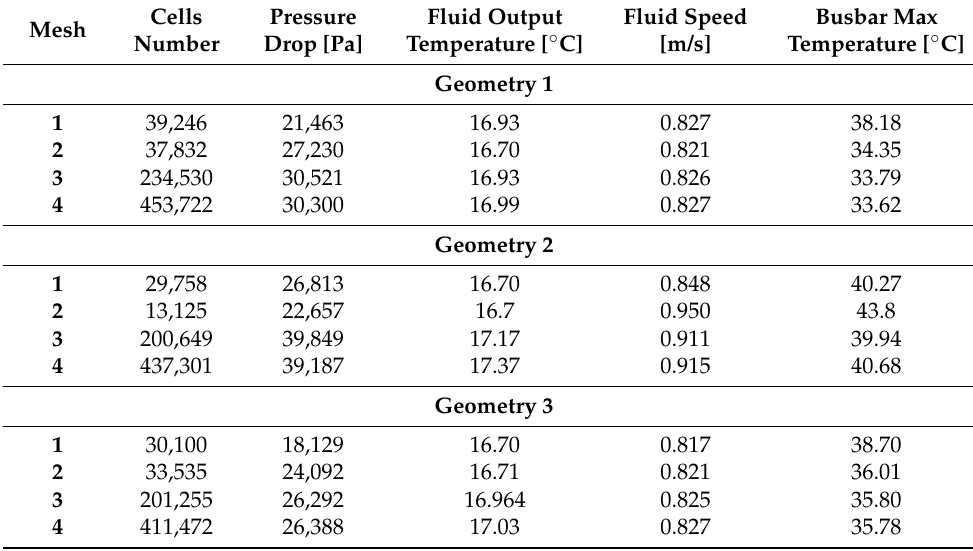
Table 7. Independent grid stability